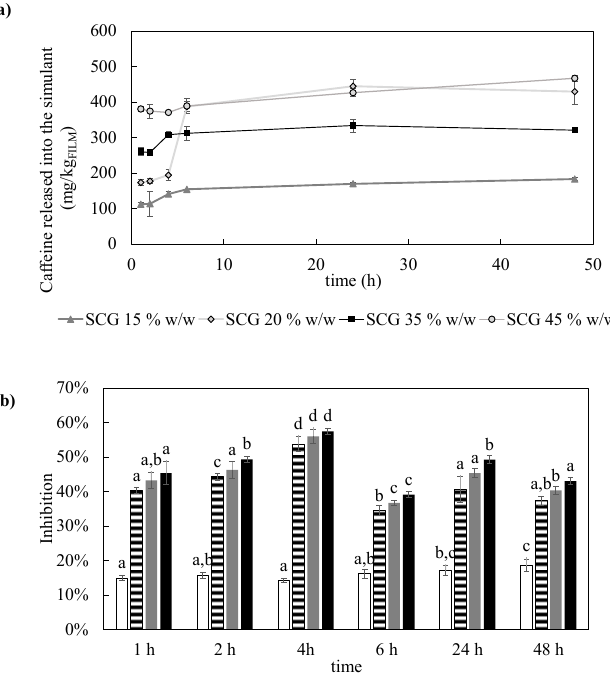
Figure 6. Results of the release tests on films obtained by spin coating in ethanol 10% ( v / v ), in terms of: ( a ) caffeine released per kg of film, ( b ) radical ABTS • + inhibition. Different symbols indicate statistically significant differences among values over time ( p < 0.05) of dataset with the same extract loading.